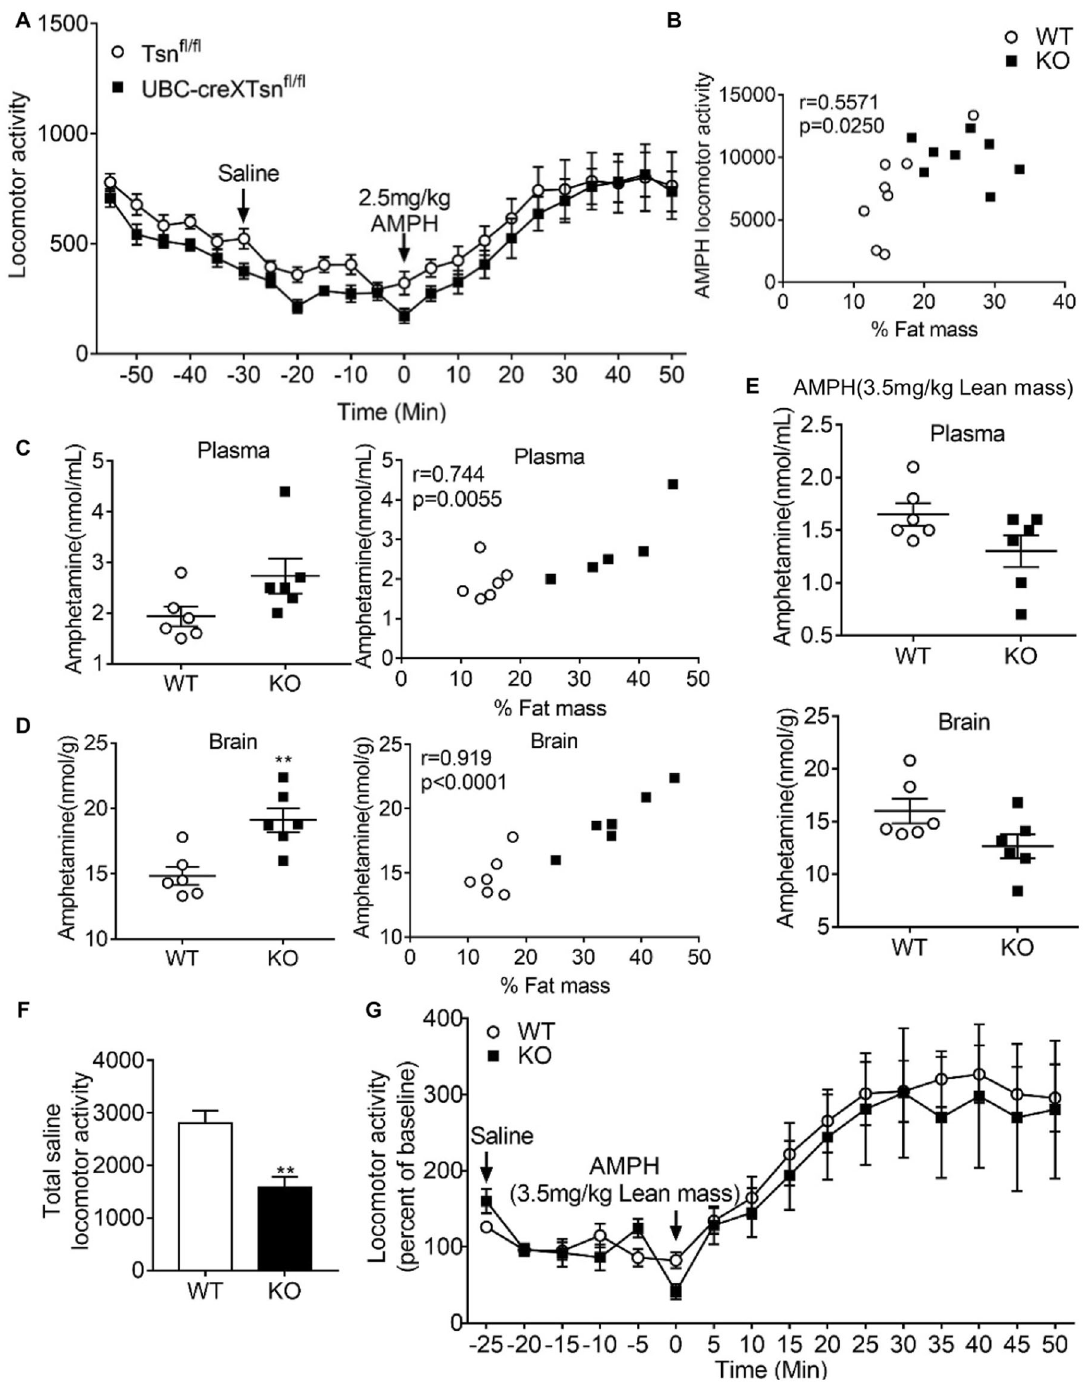
Fig. 3 Correlation of fat mass with AMPH-induced locomotor activity and AMPH levels in plasma and brain. A Global, conditional deletion of Tsn during adulthood does not affect the locomotor response to AMPH (2.5 mg/kg, i.p.). B The total locomotor activity induced by AMPH (2.5 mg/kg i.p.) in WT and Tsn KO mice was correlated with % fat mass ( r = 0.5571, P = 0.025). n = 8/group. C Plasma AMPH levels (in nmol/mL) (left), and correlation with % fat mass (right; r = 0.744, P = 0.0055). 2.5 mg/kg AMPH was injected i.p. based on body weight. n = 6/group. D Brain AMPH levels (in nmol/g) (left), and correlation with % fat mass (right; r = 0.919, p < 0.0001). 2.5 mg/kg AMPH was injected i.p. based on body weight. n = 6/group. E Plasma and brain AMPH levels when 3.5 mg/kg AMPH was injected i.p. based on lean mass. n = 6/group. F Prior to i.p. injection of 3.5 mg/kg based on lean mass, baseline locomotor activity monitored following saline injection was lower in Tsn KO mice than in WT littermates. G The normalized locomotor response to AMPH shown as a percentage of the baseline level (100%) is comparable between groups. n = 7-8/group. Data are expressed as Mean ± SEM. Statistical signi fi cance indicated by asterisks was assessed by Student ’ s t - test. ** p <